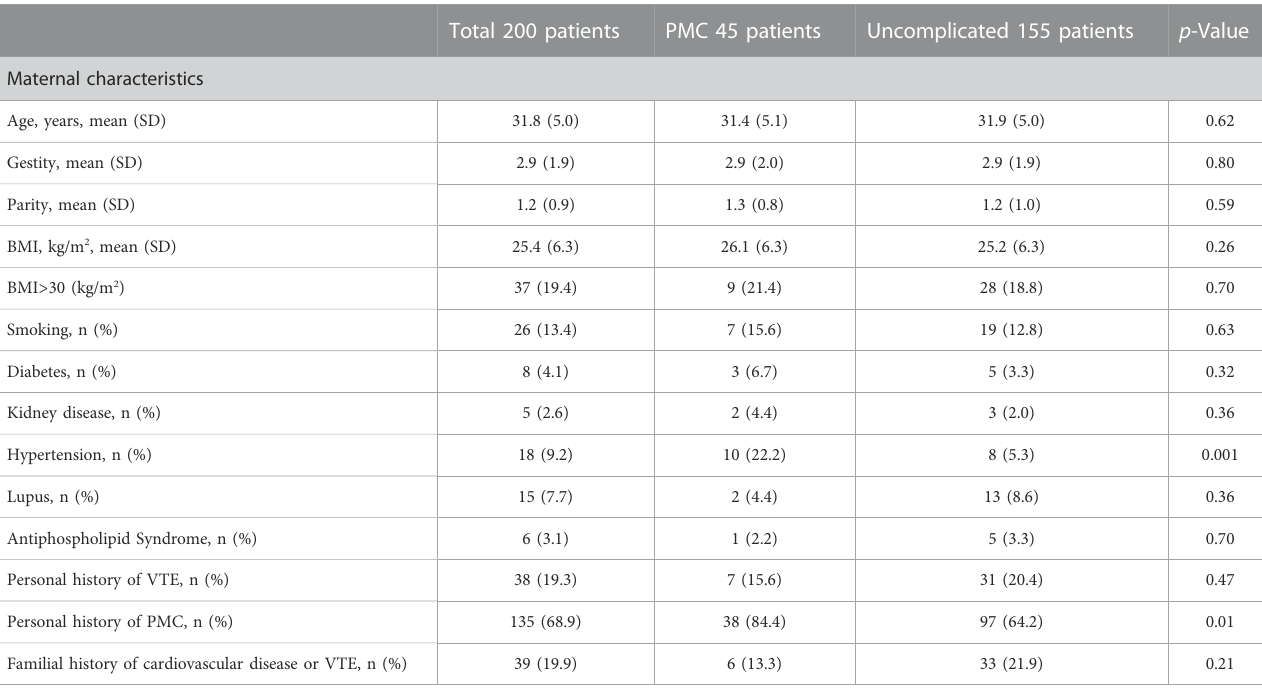
TABLE 1 Patient characteristics at